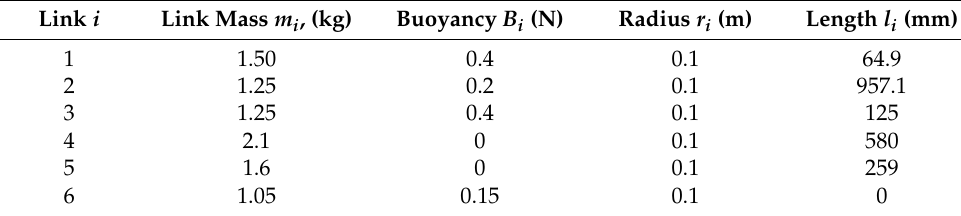
Table 2. D ‐ H parameters.